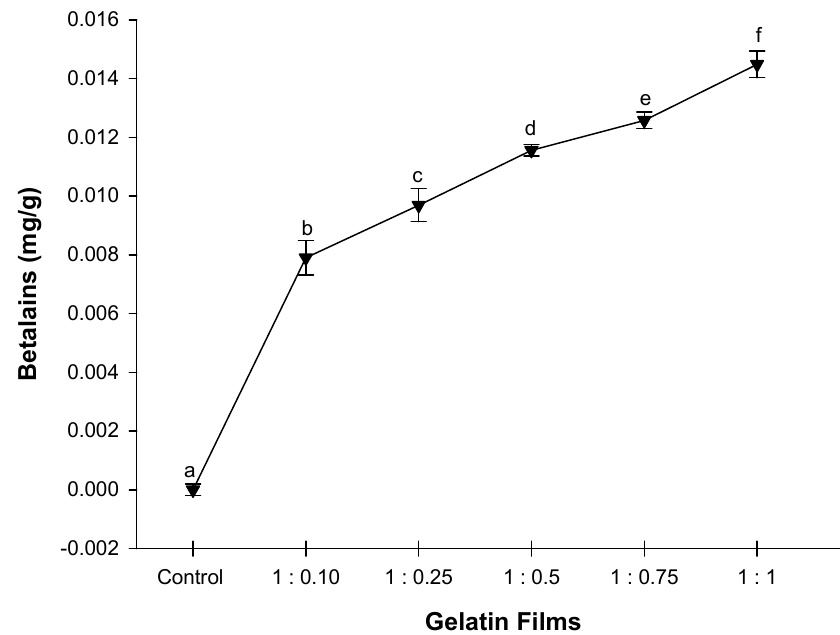
Figure 1. Concentration of betalains present in gelatine films with added nanoemulsion (W/O) xoconstle fruit extract–orange oil. Values with the same letter within the line are not statistically different values according to the Tukey test ( p < 0.05).